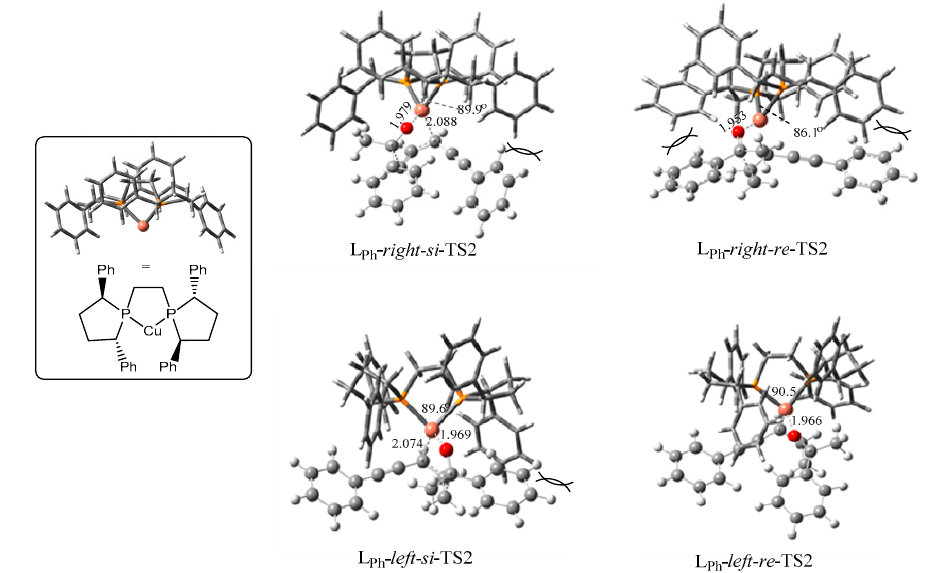
Figure 5. Three-dimensional (3D) model of stereo-controlling transition states ( TS2 s) at the M06/6-31G(d,p) level in the ( S,S )-Ph-BPE ligand system. Table 1. Δ G values of competing TS2 s in the ( S,S )-Ph-PBE system. TS2s P-cu-p Angle Configuration of Products Δ G (kJ/mol)